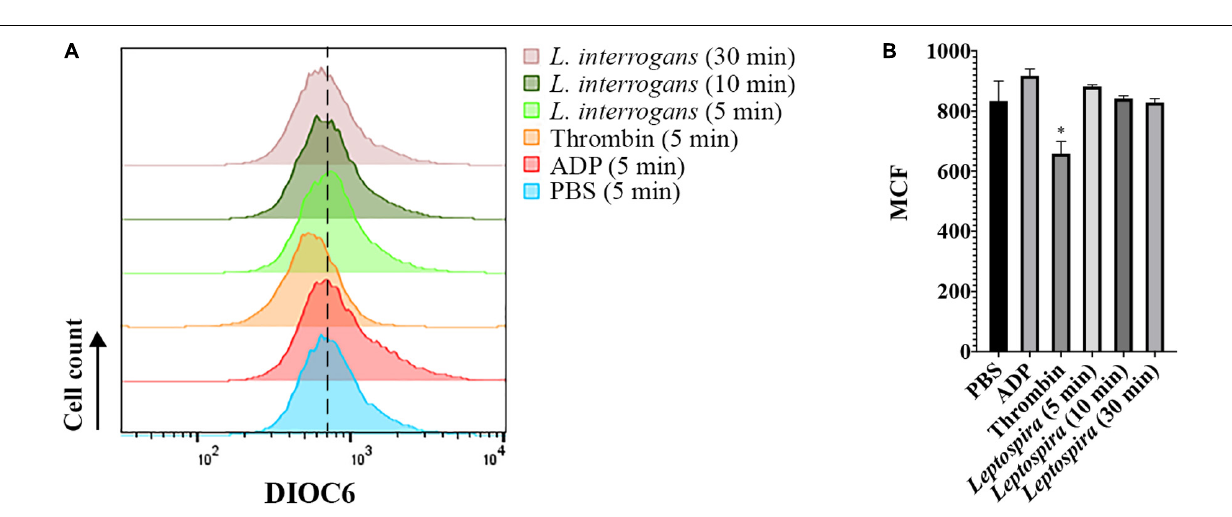
adjacent activated platelets to form aggregates, by binding to fibrinogen. Changes in the state of GPIIbIIIa activation closely correlate with the degree of platelet-platelet aggregation (Frelinger,